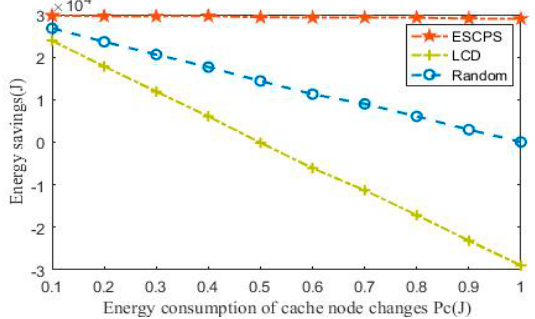
Figure 2. The effect of cache node change energy consumption on energy savings.